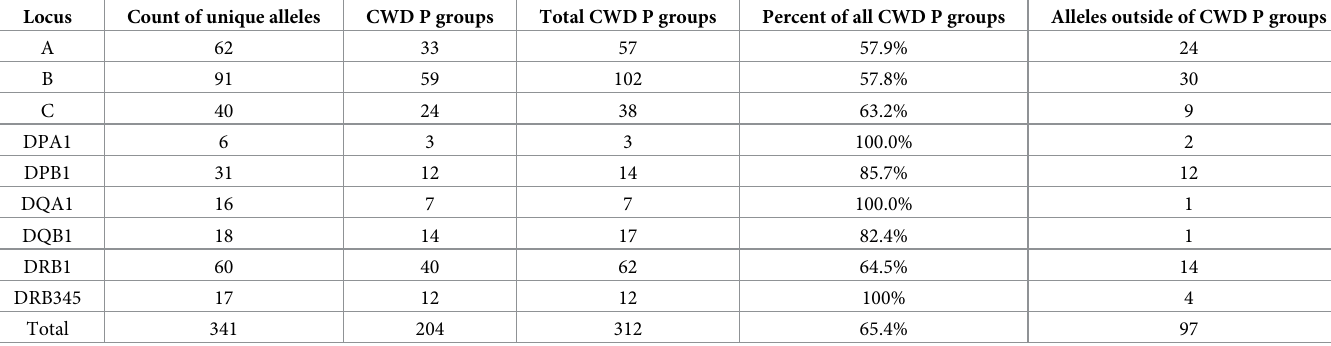
Table 1. Number of unique alleles, CWD P groups, non-CWD alleles in this